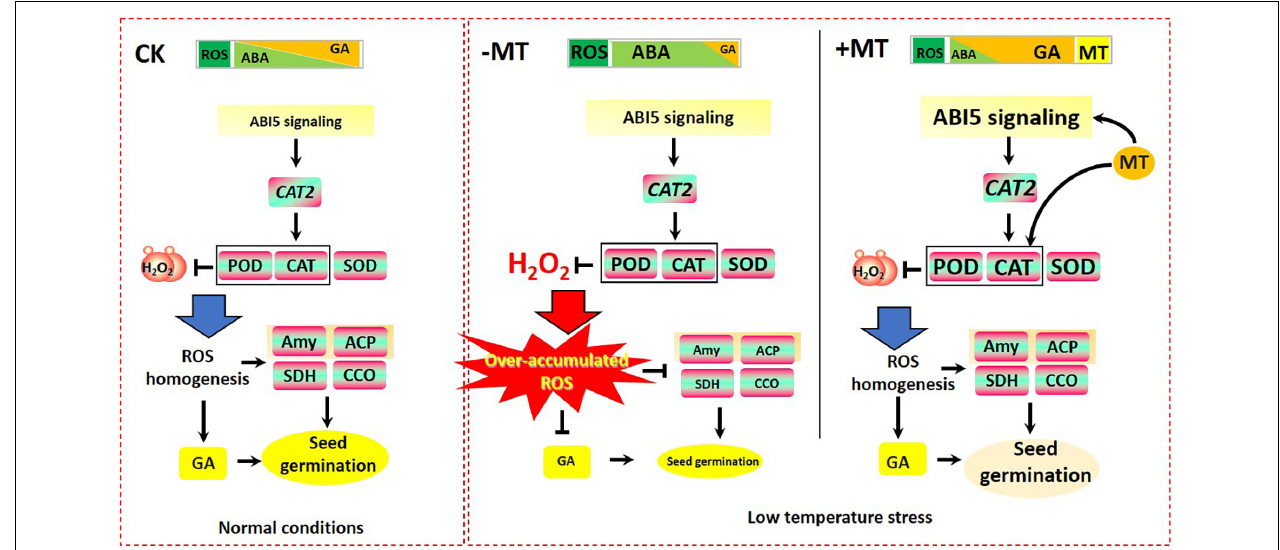
FIGURE 9 | Models for explaining the alleviated effects of MT on LT-stressed seed germination in rice. During seed germination, LT stress caused the accumulation of reactive oxygen species (ROS) and ABA, which was helpful to maintain seed dormancy. However, the disruption of redox homeostasis caused by LT stress-induced ROS accumulation greatly suppressed the biosynthesis of GA and the efficient applications of storage materials (i.e., soluble sugar), to eventually prevent seed germination. However, MT treatment greatly activated OsABI5 to regulate OsCAT2 and promoted the antioxidant systems (i.e., SOD, POD, and CAT) to scavenge ROS, which would consequently restore the steady states of ROS homeostasis in the germinating seeds; the homeostasis of ROS, in turn, enabled the promotion of the catabolism of ABA, which finally relieved the inhibitions for seed germination and simultaneously contributed to the biosynthesis of GA as well as the effective functioning of enzymes involved in seed germination (i.e., Amy, ACP, SDH, and CCO), and thereby promoting seed germination.